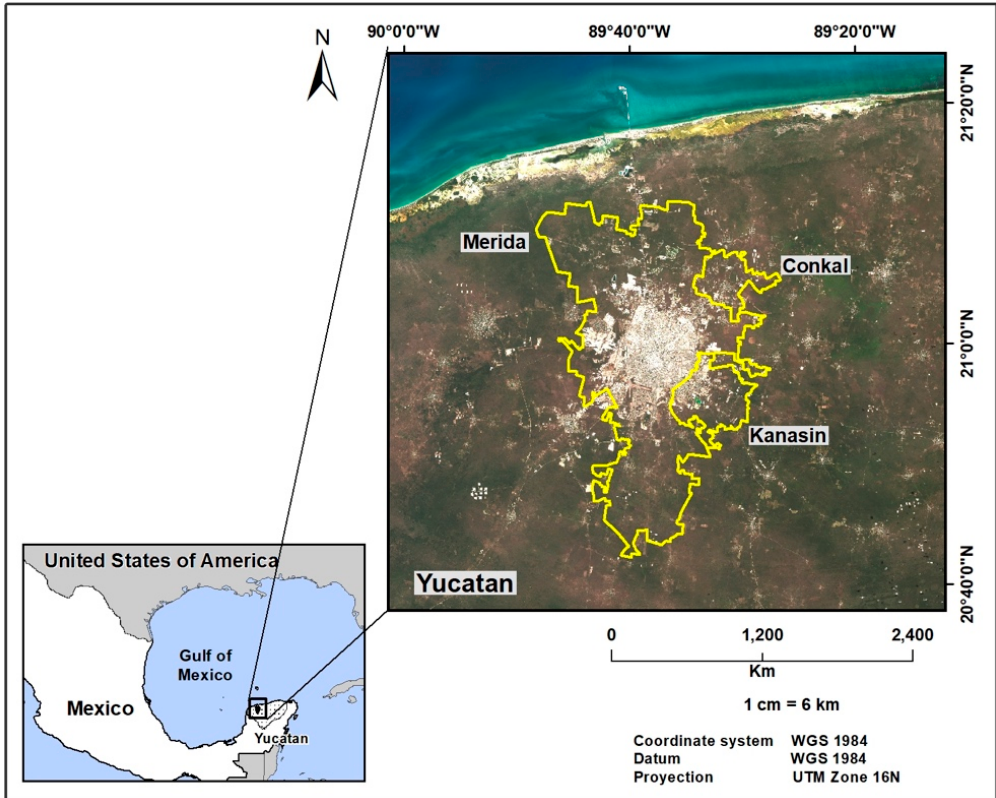
Figure 1. Study area: urban zone of Mérida, Yucatán, Mexico.